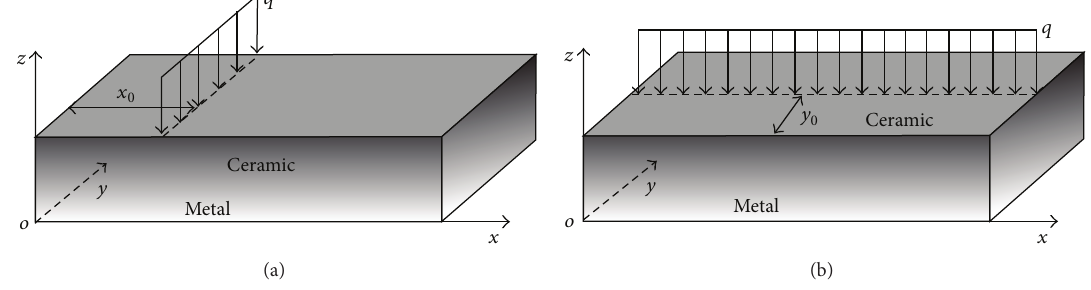
Figure 3: FGM plate subjected to line load: (a) the line load 𝑞(𝑥,𝑦) = 𝑞 0 𝛿(𝑥 − 𝑥 0 ) and (b) the line load 𝑞(𝑥, 𝑦) = 𝑞 0 𝛿(𝑦 − 𝑦 0 ).